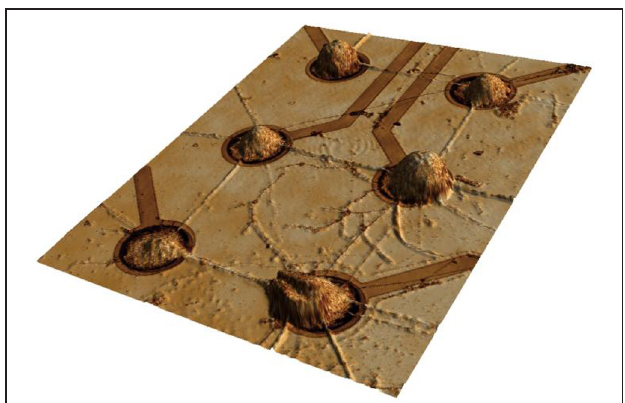
FIGURE 3 | A neuro-glia cortical culture from embryonic rats grown on a carbon nanotube micro electrode array. Clusters of cells self-organized during culture development to position themselves on the electrodes. The distance between electrodes is 200 µ m. Image acquired using a 3D confocal microscope (Shein et al.,